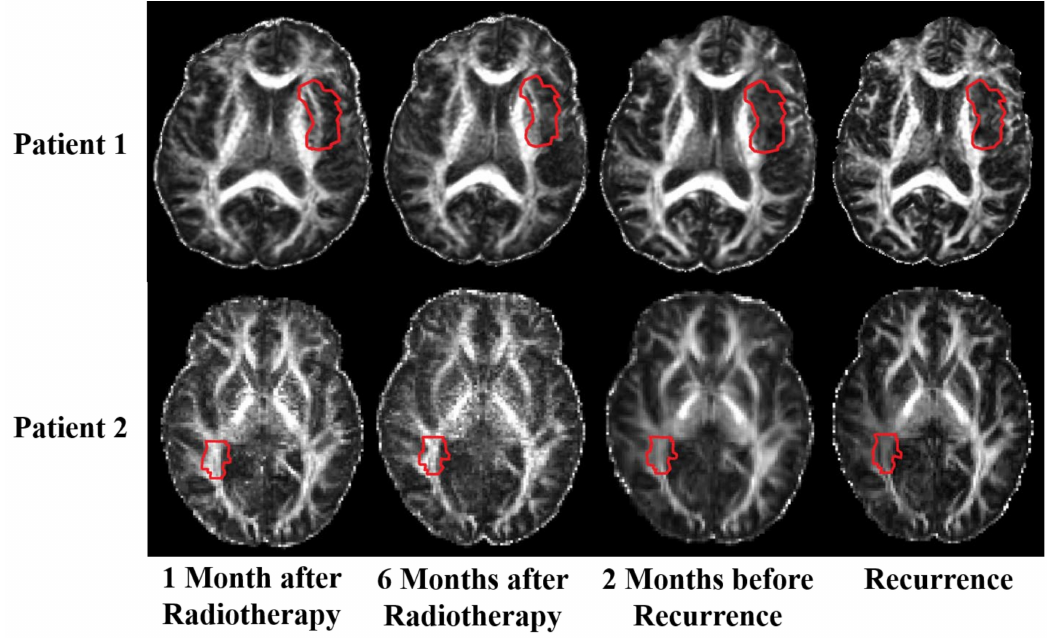
Figure 5. Serial fractional anisotropy (FA) images of two representative patients at four time points, including 6 months after radiation therapy. Red outlines indicate the location of the recurrent